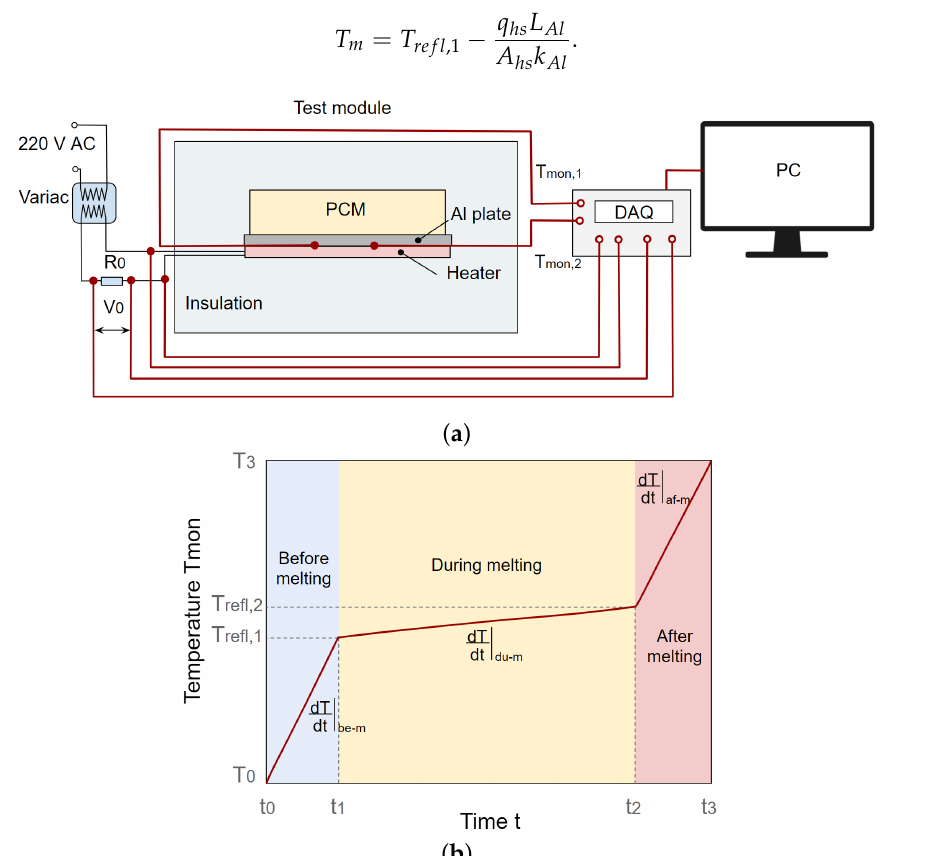
Figure 6. ( a ) Schematic of the measurement device; ( b ) Schematics of a temperature response under constant heating power q hs . Adapted from